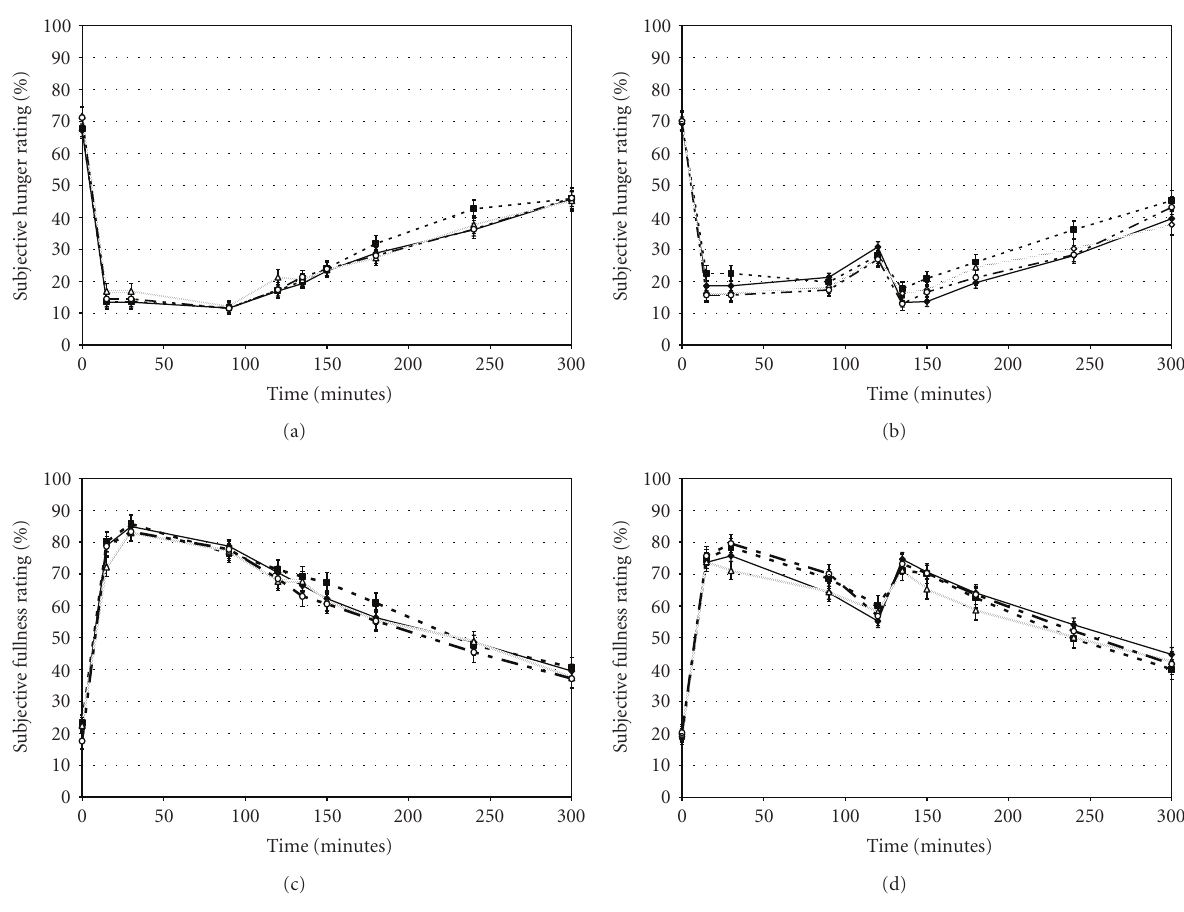
Figure 3: Appetitive ratings for each treatment load. Data are mean (SD) ratings from participants during each session control (triangle), peanut (square), snack mix (diamond), and snack mix with peanuts (circle). Panels (a) and (b) depict hunger ratings from meal and snack sessions, respectively, and fullness ratings are shown in panel (c) for meal sess ions and panel (d) for snack sessions. Peanut n = 66; Snack Mix n = 68; Snack Mix with Peanut n = 67; Control n =